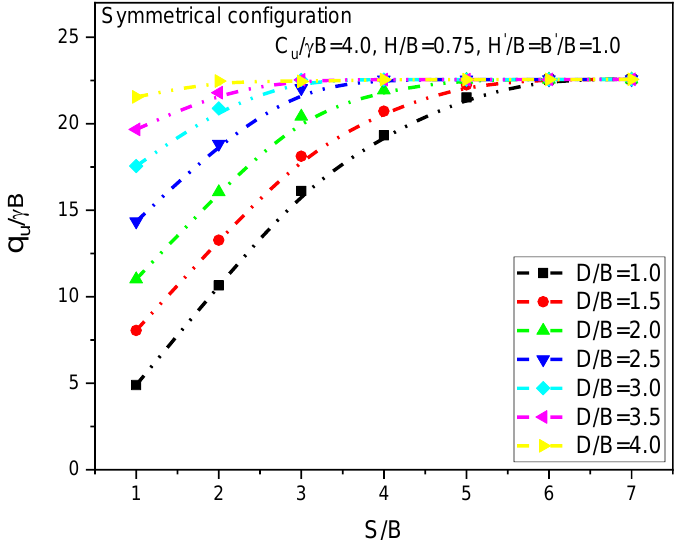
Figure 12. Effect of the symmetrical configuration on the ultimate bearing capacity ratio qu/γB (two voids).